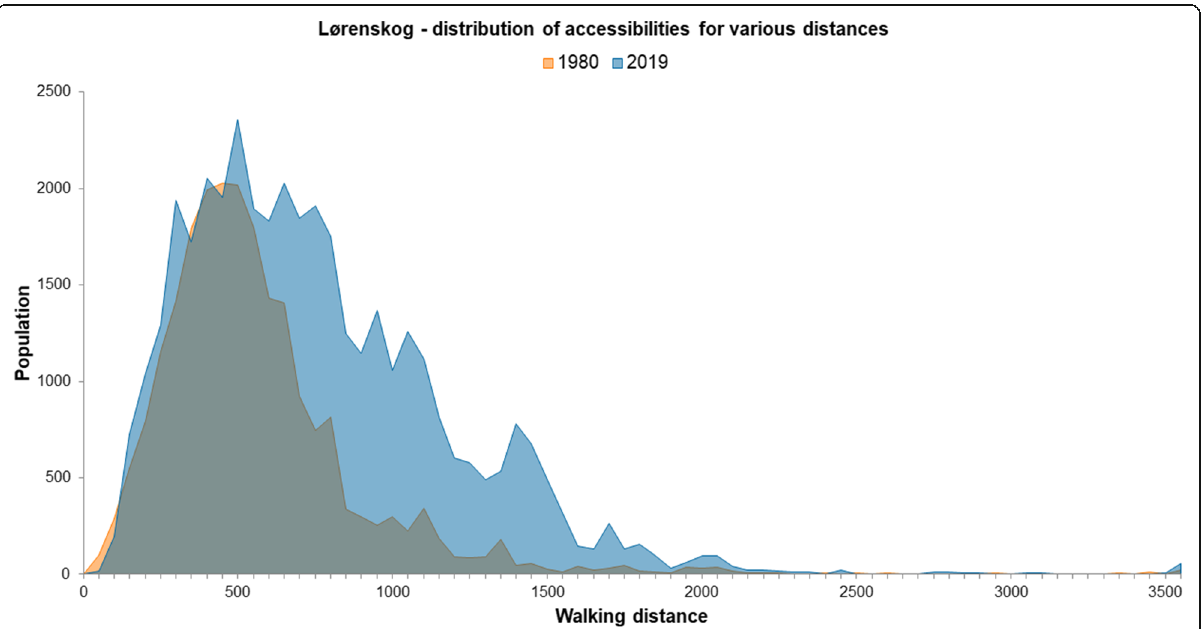
Fig. 8 Accessibility from dwellings to grocery stores in Lørenskog, Population at different distances in 50 m intervals, 1980 (orange) and 2019